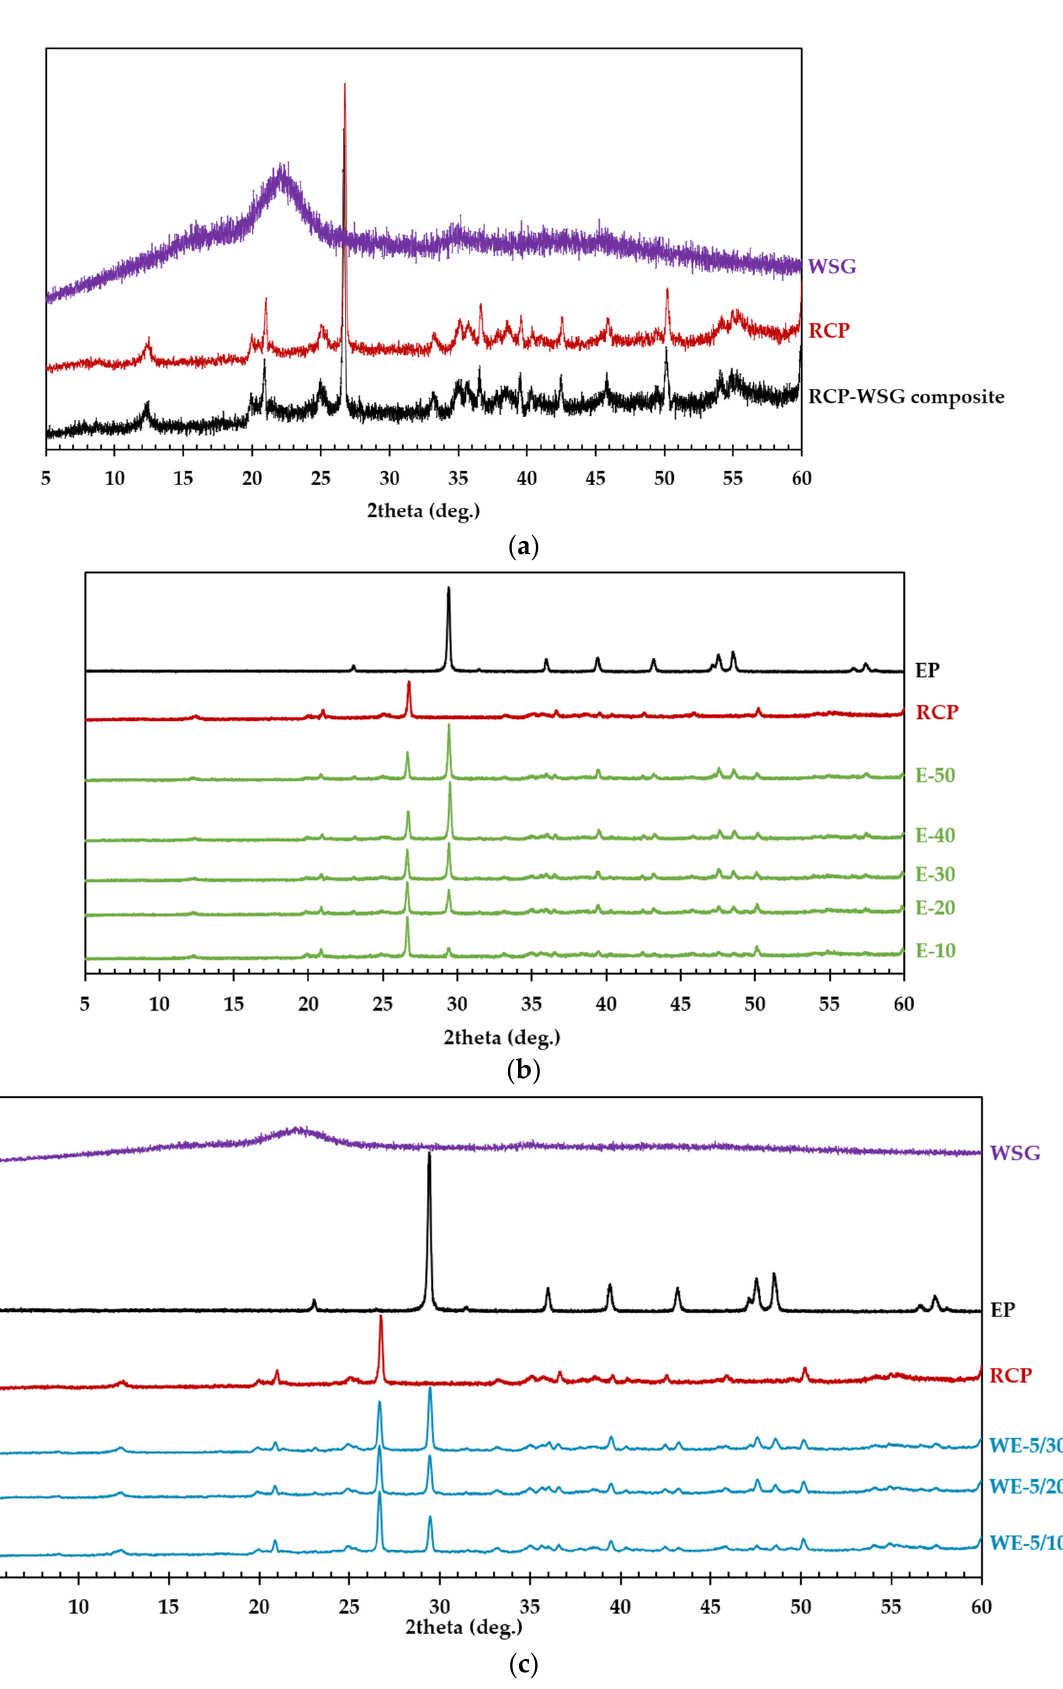
Figure 7. XRD spectrograms of composites: ( a ) WSG samples; ( b ) EP samples; ( c ) WE samples.